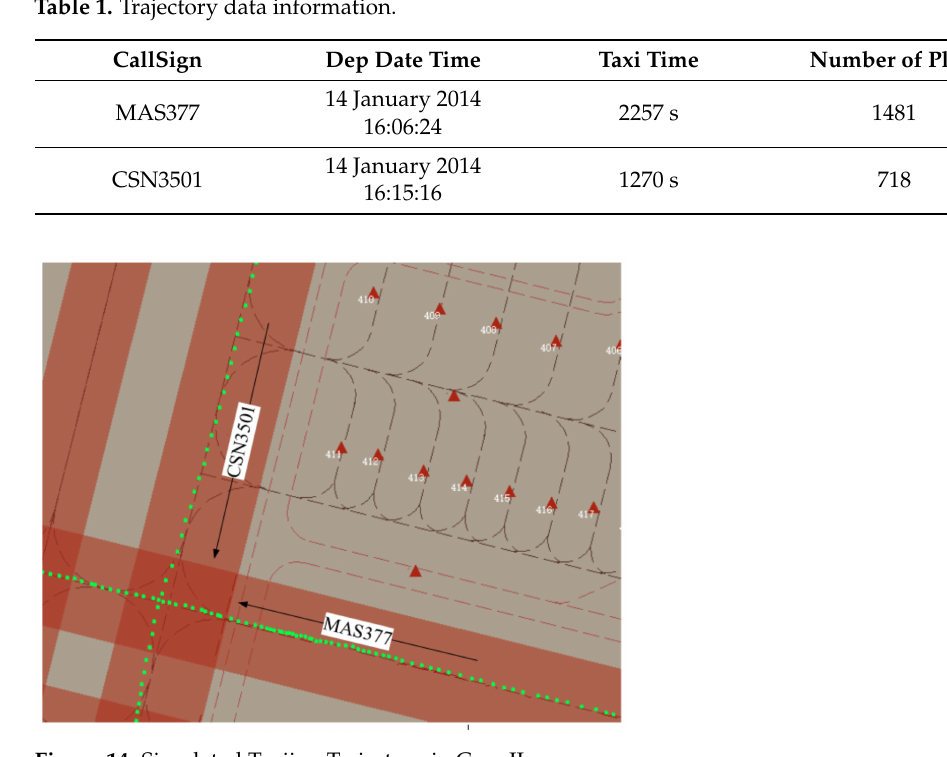
Figure 14. Simulated Taxiing Trajectory in Case